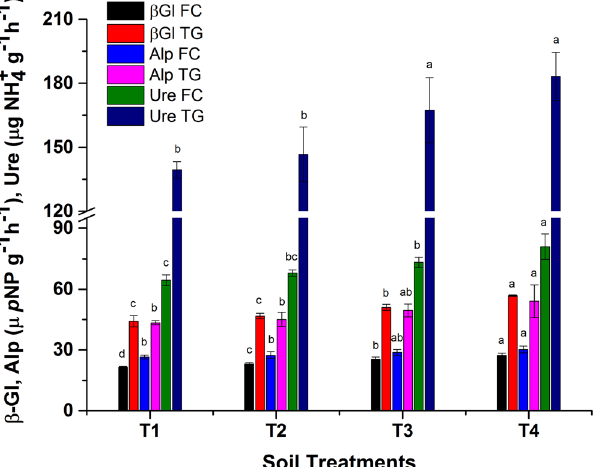
Figure 7. Effect of bamboo biochar on the soil enzymatic activities of Feng county and Tongguan. The data represent the mean of three replicates, and error bars are standard deviations. Means with different letters are significantly different ( p < 0.05). (T1 = Control, T2 = 1.0% BB, T3 = 2.5% BB, T4 = 5.0% BB).